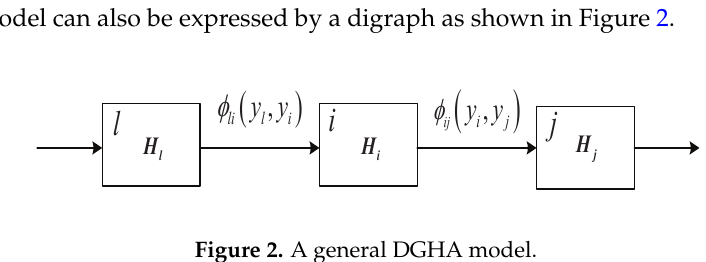
Figure 2. A general DGHA